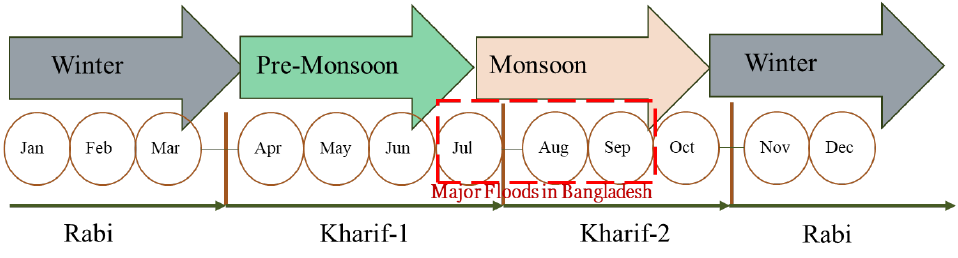
Figure 5. Crop calendar during major flooding time in Bangladesh.